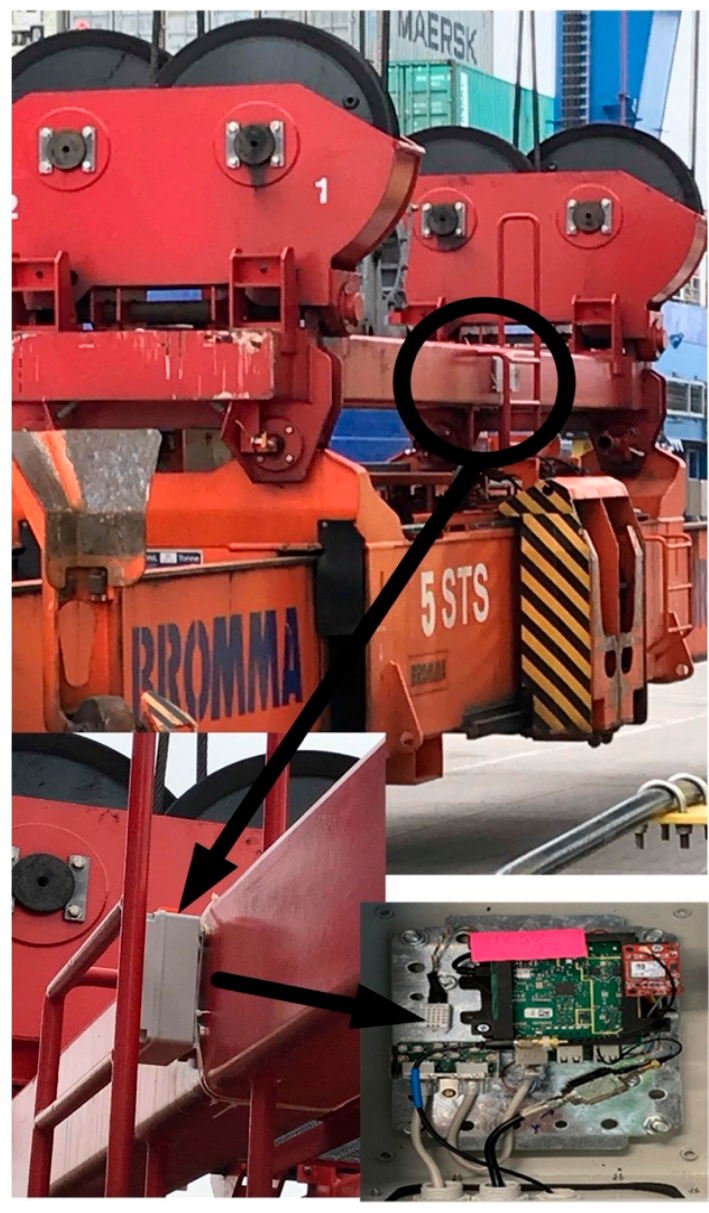
Figure 5. Positioning of the embedded sensory device on the spreader of the QC.